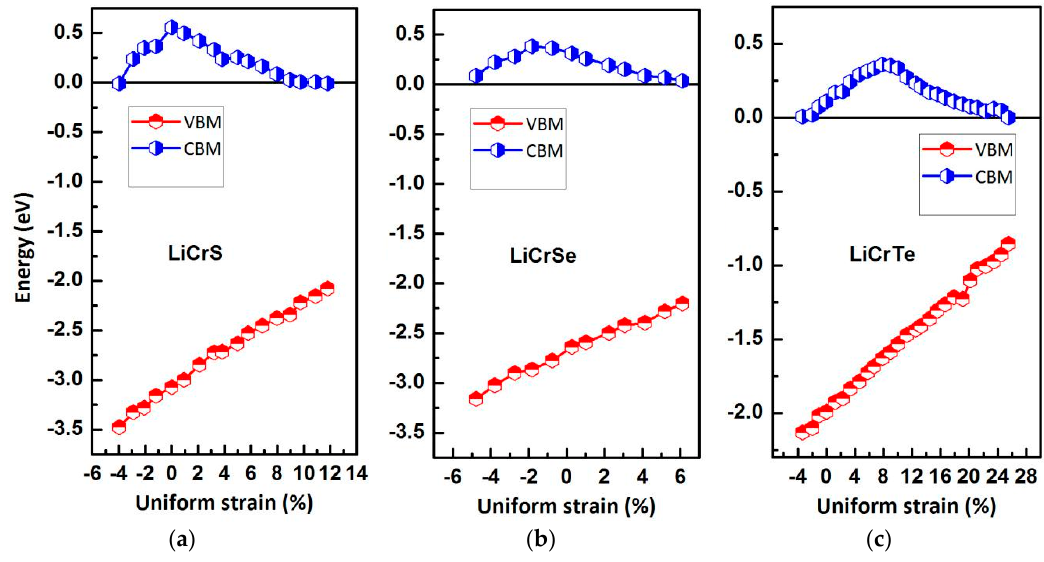
Figure 7. Calculated valence band maximum (VBM) and conduction band minimum (CBM) as a function of the lattice constants for the LiCrS ( a ), LiCrSe ( b ) and LiCrTe ( c ) alloys in the type II arrangement. The black circle and the red circle represent the VBM and CBM, respectively. (The Fermi level E F was set as Y = 0).